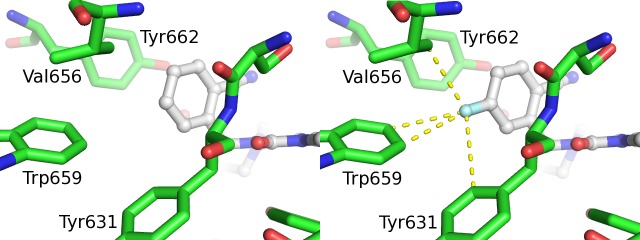
Potential fluorine atom interactions in trelagliptin x-ray crystal structure.Close-up showing potential differential interaction of F-atom of trelagliptin (right panel) with Trp659 residue in DPP-4 crystal structure as compared to H-atom of alogliptin (left panel).